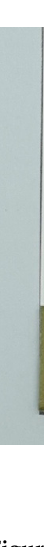
Figure 2. The MTT-PMS test strips: ( a ) MTT-PMS test strips prior to submersion into solution; ( b ) MTT-PMS test strips following submersion and incubation.